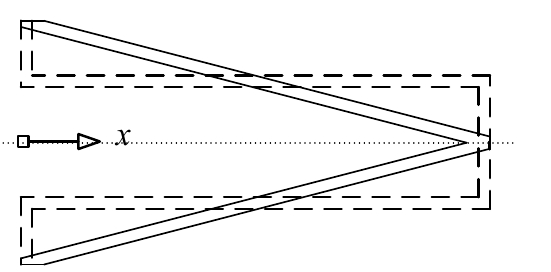
Figure 6. Comparison of the width of rectangular ( A / w = 0.5) and triangular ( A / w = 0) plan shapes.